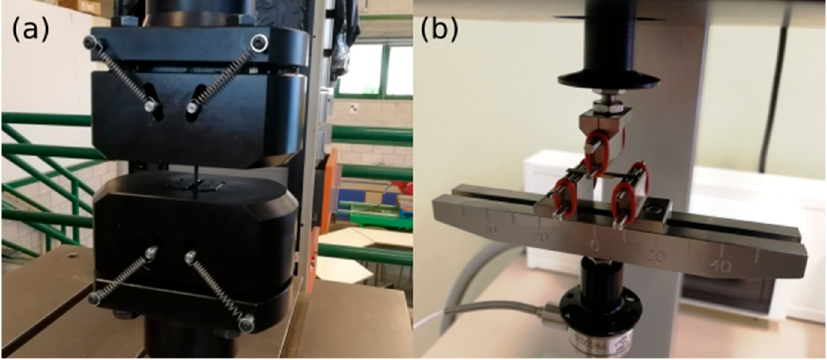
Figure 5. Representative image of the adhesion ( a ) and tensile ( b ) tests performed in the current study.